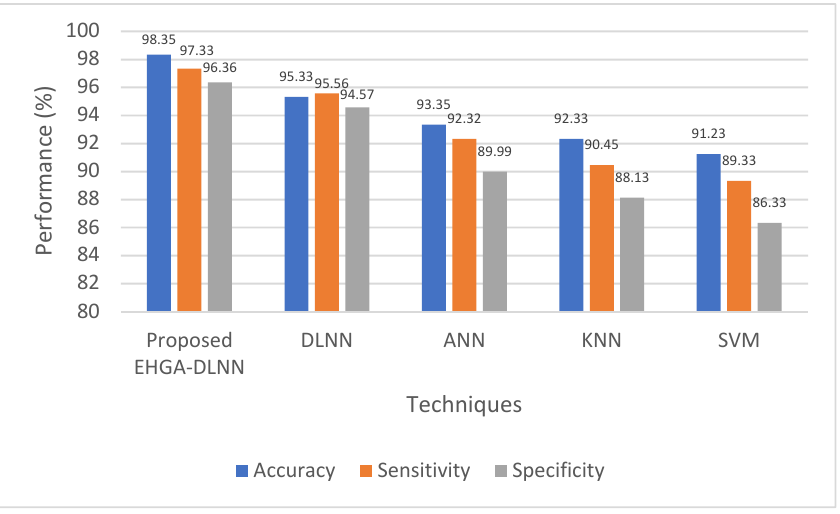
Figure 4. Comparative analysis of the proposed methodology with the existent methodologies.